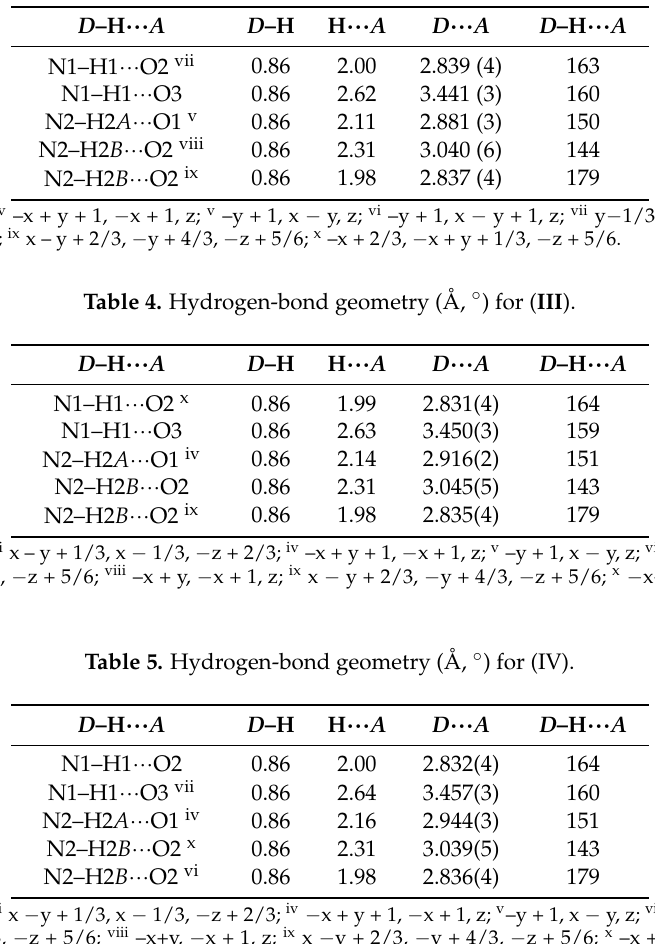
Table 3. Hydrogen-bond geometry (Å, ◦ ) for (II).